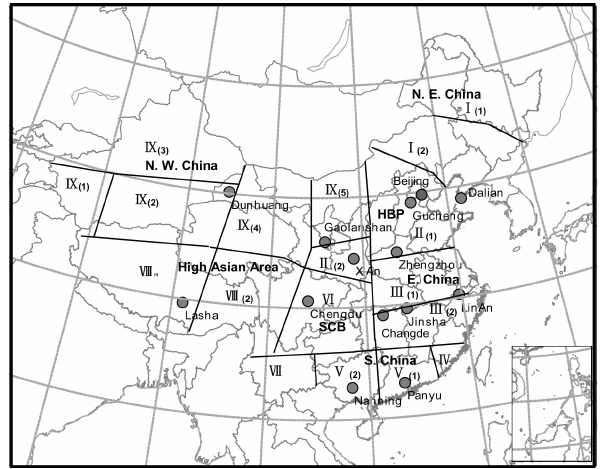
Figure 1. Locations of thirteen CAWNET stations and nine similar visibility changing regions in China (X. Y. Zhang et al.,